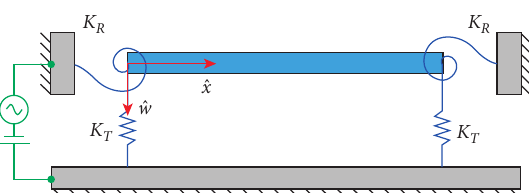
Figure 1: Schematic diagram of one-electrode microbeam with nonideal boundary